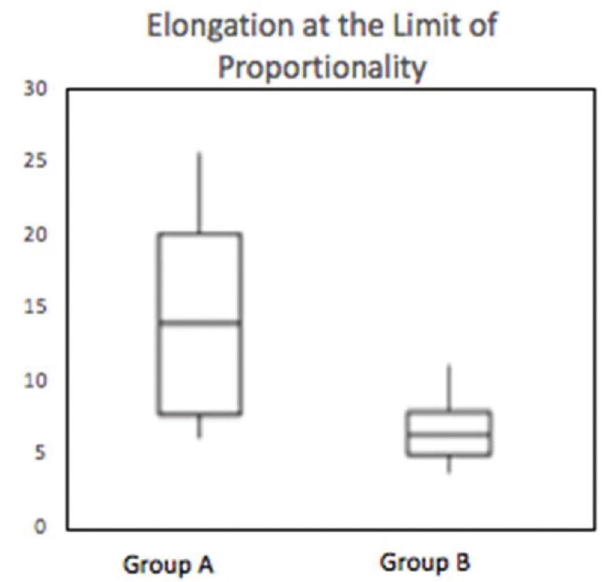
Figure 9 - Box-plot demonstrating the distribution of the elonga- tion at the limit of proportionality (mm) of groups A and B ( p =0.003).